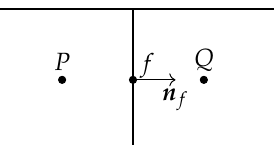
Figure 1. Illustration of mesh cell P and its neighbor cell Q , with their shared face f and its unit normal vector n f (pointing out of cell P